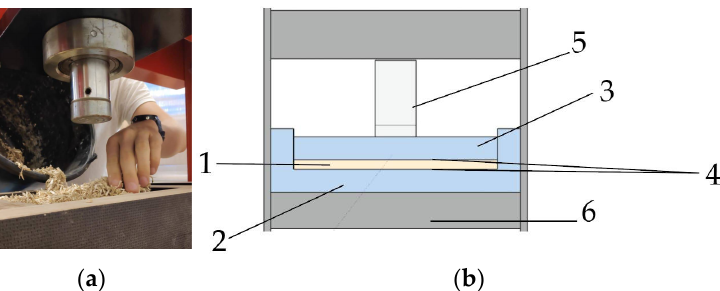
Figure 2. ( a ) Formation of mixture into the mold; ( b ) forming setup of hydraulic press and mold: 1—Hemp shive mass that is formed into board; 2—bottom part of the mold; 3—punch; 4—layers of non-stick paper; 5—hydraulic jack, 6—hydraulic press stand.